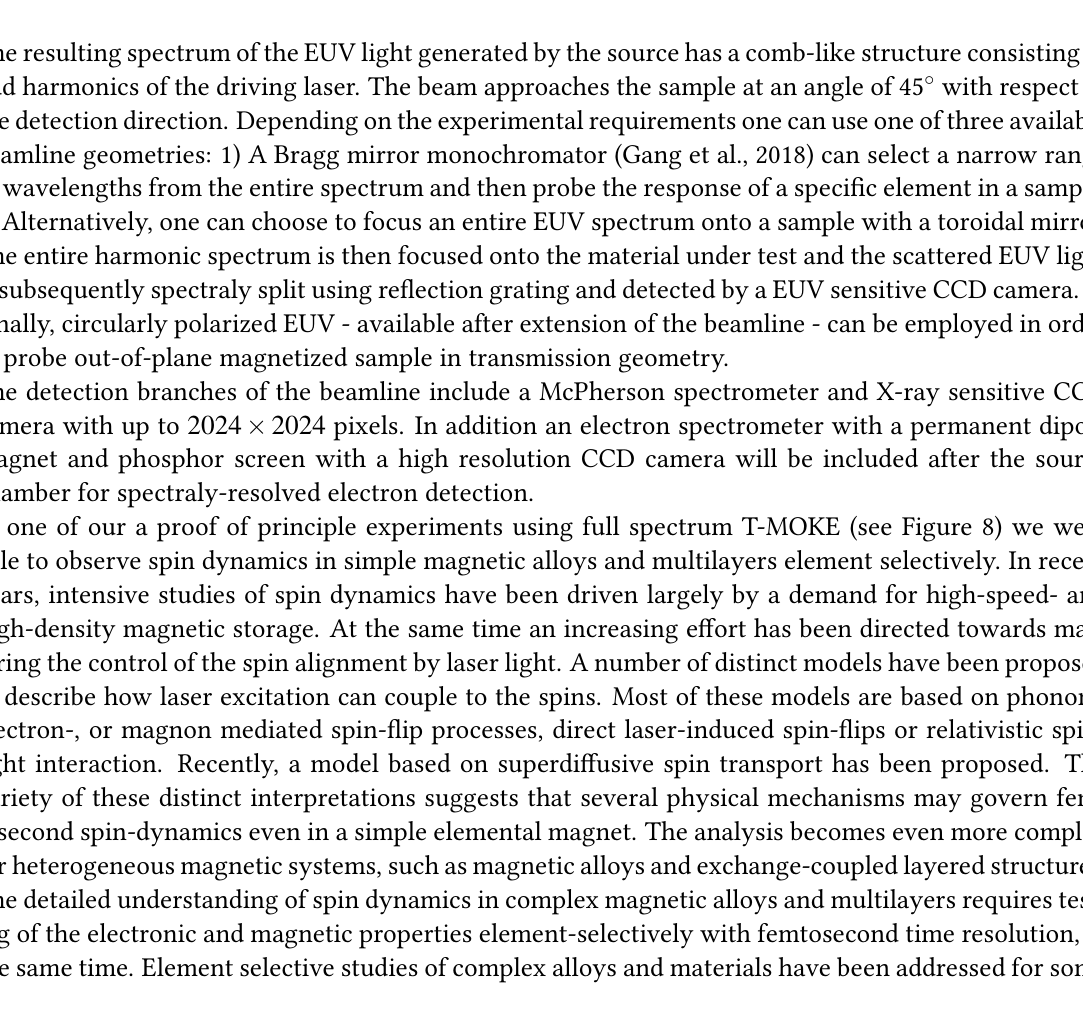
Figure 7: HHG beamline for high-energy photon and electron scattering experiments. From right to left: focusing chamber, HHG source chamber containing the gas cell, monochromator, and experiment and detection chambers. The high-energy photon beam is generated and guided inside vacuum to avoid scattering in